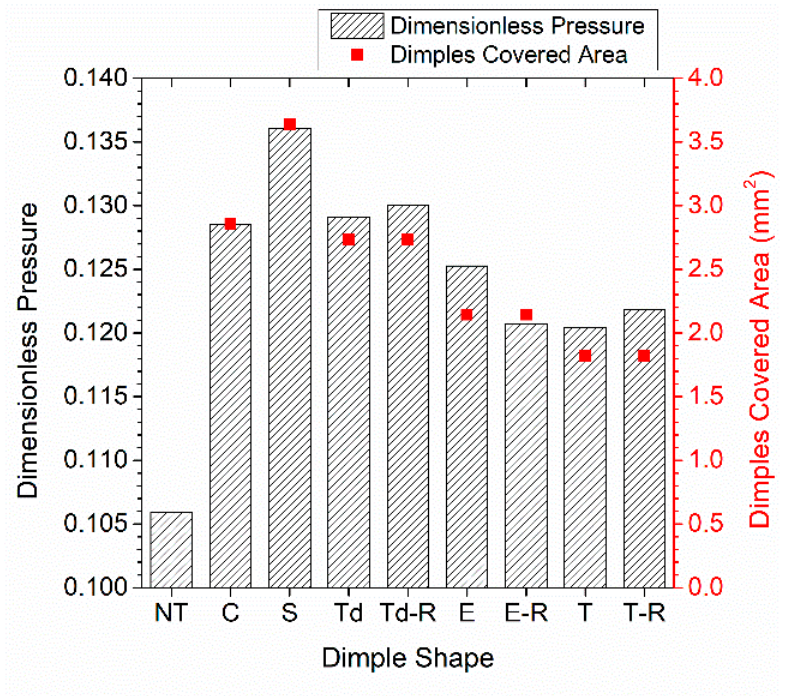
Figure 6. Comparison of average pressure on the top surface of the model for the different dimple shapes: non-textured (NT), circle (C), square (S), ellipse (E), rotated ellipse (E-R), trapezoid (Td), rotated trapezoid (Td-R), triangle (T), rotated triangle (T-R).